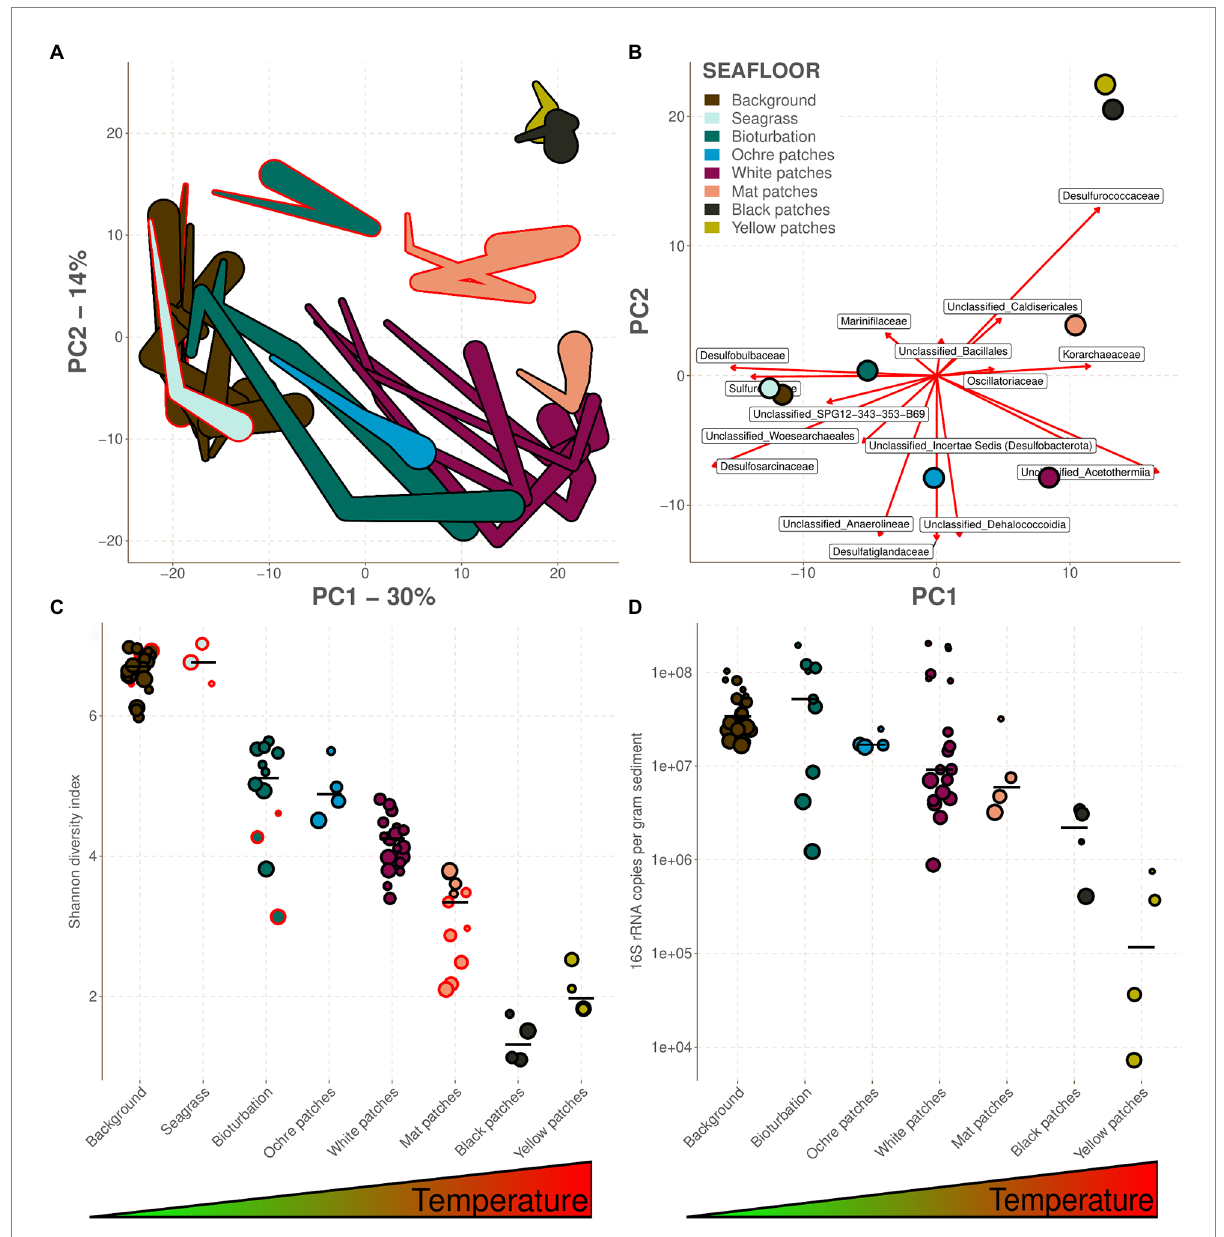
FIGURE 2 Heterogeneity between the different seafloor types. The color legend as given in B is true for the whole figure. Samples from the Saganaki dataset have a red border, while the ones from the CarDHynAl dataset have a black border. (A) Form CoDa-biplot, representing 44% of the variance. It approximately reflects the Aitchison distances between the 16S rRNA composition of the sample at the family taxonomic level. Each linked samples represent a core, with the width of the link being proportional to depth of the sample. (B) Covariance CoDa-biplot where the center of each seafloor type is shown, as well as the taxa involved in the balances described in the text. (C) Shannon diversity index of each sample grouped per seafloor type. (D) Absolute prokaryotic abundance as copies of 16S rRNA per gram of sediment quantified by qPCR. For (C,D) , the seafloor types are ordered by increasing temperature/hydrothermal influence, and the bars represent the